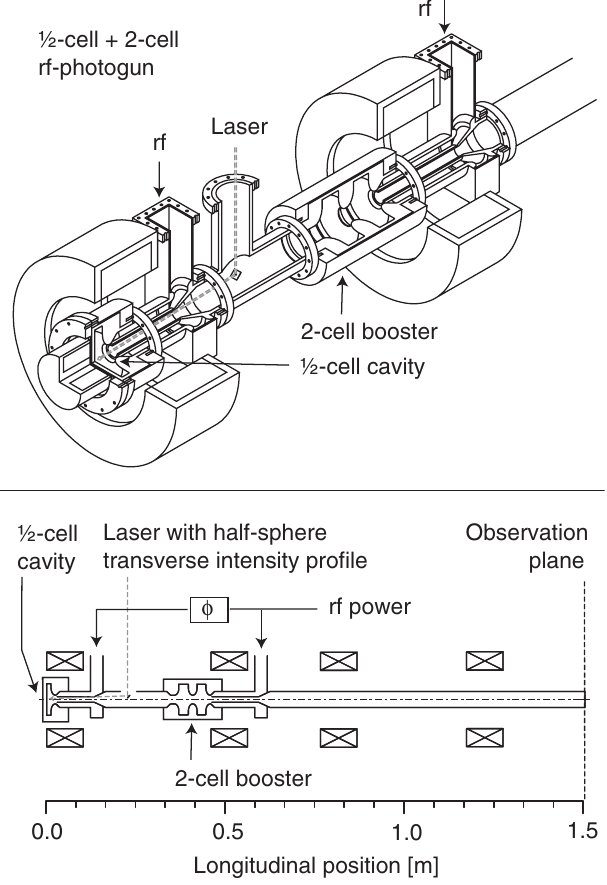
FIG. 1. Schematic of the proposed